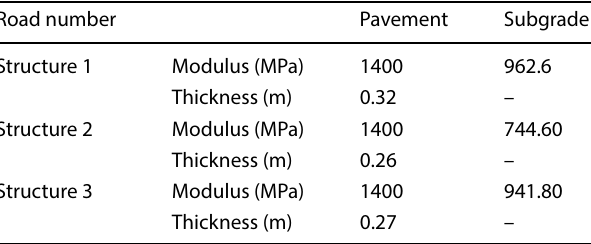
Table 1 Structural parameters of layers of the asphalt pavement in the field test Road number